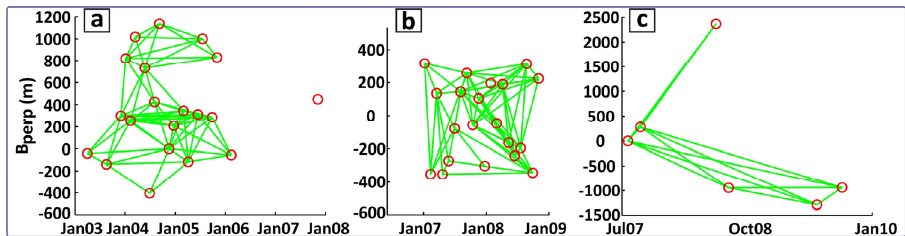
Figure 4. Shaded relief map of the study area. Black boxes represent SAR coverage from ALOS, Ascending Envisat (ASC) and Descending Envisat (DES). The inset map shows location of the study area in Iran. The Location of CGPS and SGPS located in the study area are depicted by square and circle, respectively. The dashed line shows the location of the profile used for Mosha fault analysis.